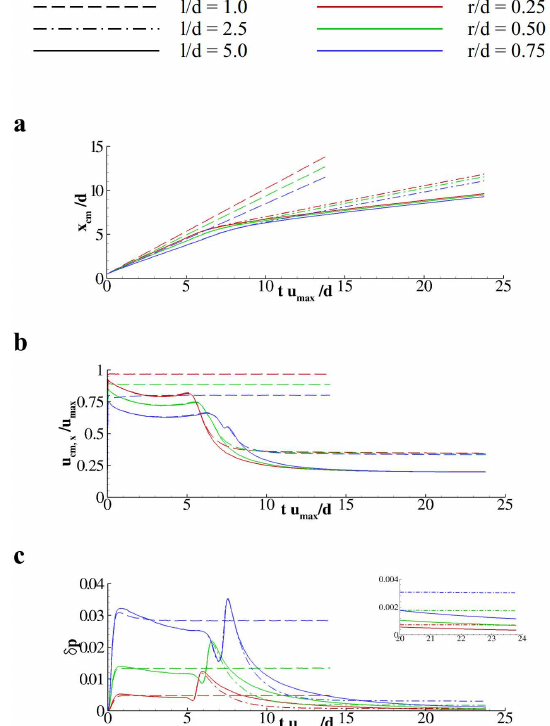
Figure 4. Injection of a capsule in a reservoir. ( a ) distribution of the x -coordinate of the capsule centre of mass x cm over time; ( b ) distribution of the x -velocity of the capsule centre of mass u cm , x over time; ( c ) distribution of the capsule stretching computed as the relative difference between the current, p , − p 0 and the initial, p 0 , perimeter of the capsule ( δ p = p p 0